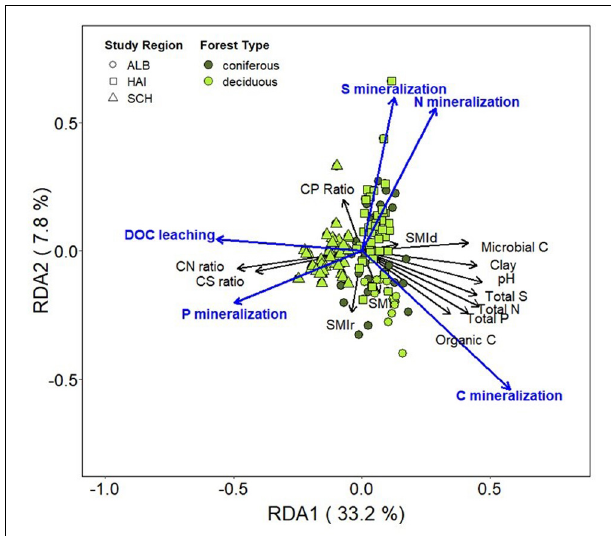
FIGURE 6 | Biplot of redundancy analysis (RDA) showing net C, N, P, and S mineralization rates ( µ g DW − 1 day − 1 ) as responses variables and soil properties (organic C, microbial C, soil pH, total N, P, and S concentrations, and soil C:N, C:P, and C:S ratios) and the SMI as predictor variables. Study regions are denoted by: ALB, Schwäbische-Alb; HAI, Hainich-Dün; SCH, Schorfheide-Chorin.